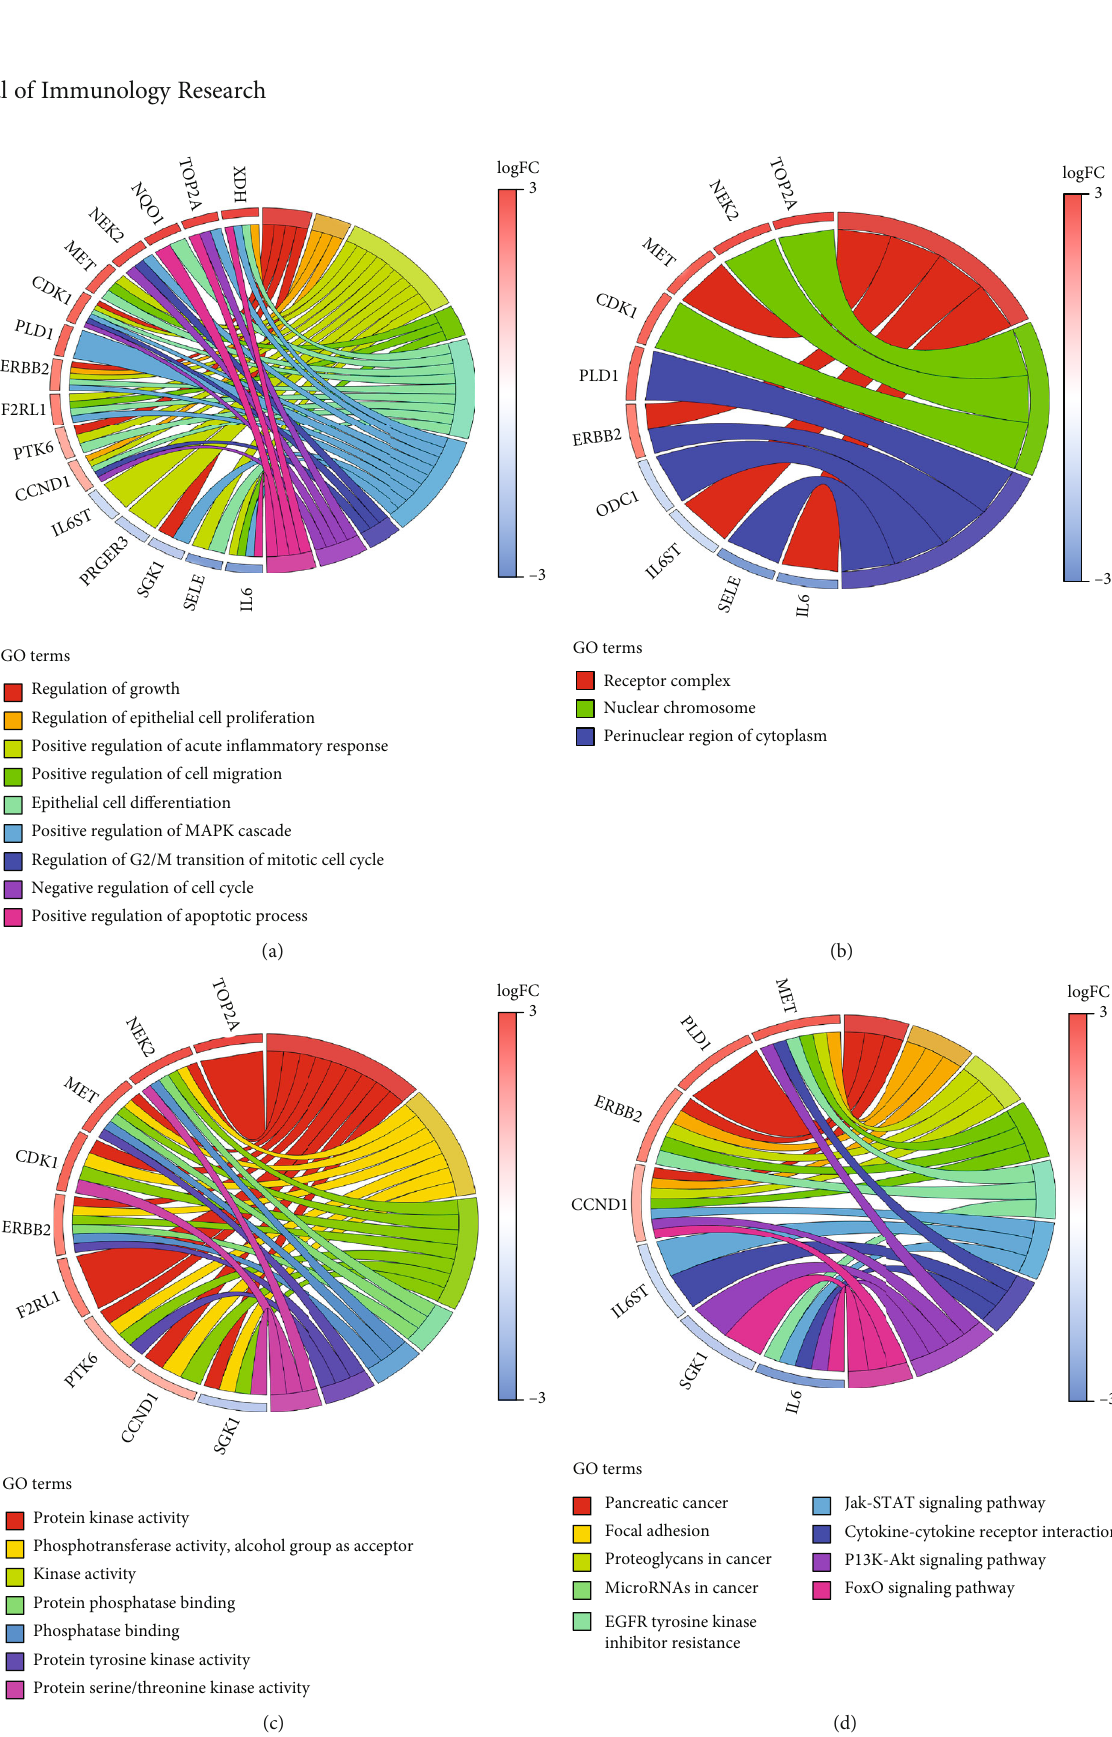
Figure 6: Functional enrichment analysis of 18 overlapped DEGs. (a) Chord plot of biological process. (b) Chord plot of cellular component (c) Chord plot of molecular function. (d) Chord plot of KEGG pathways. DEGs:di ff erentially expressed